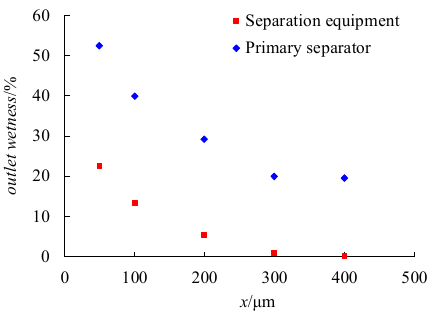
Figure 4. Outlet wetness of separation equipment and primary separator.